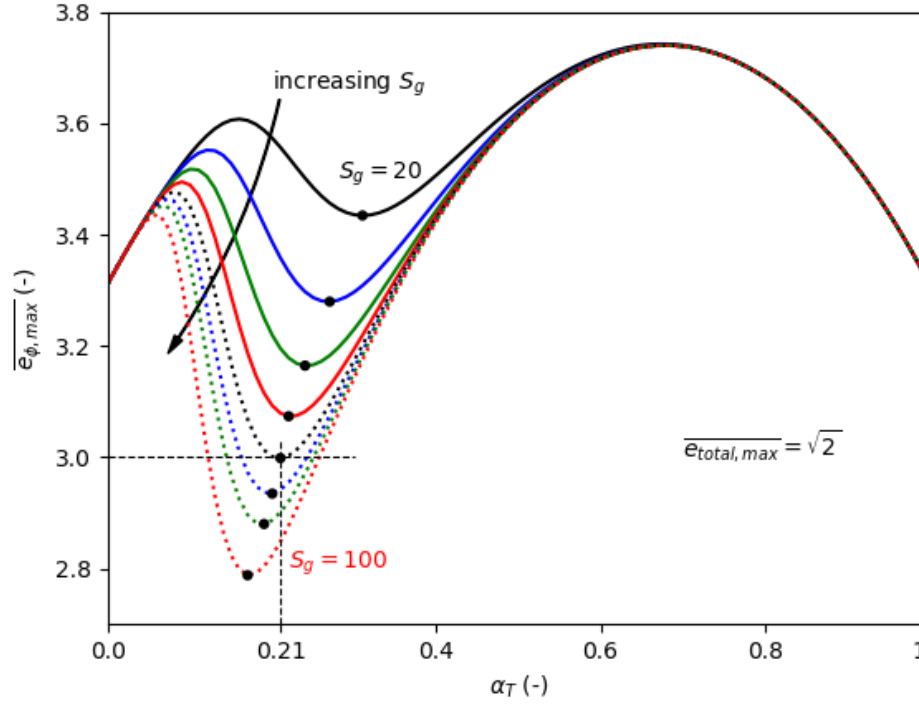
Figure 14. Maximum normalized diameter error for S g values in